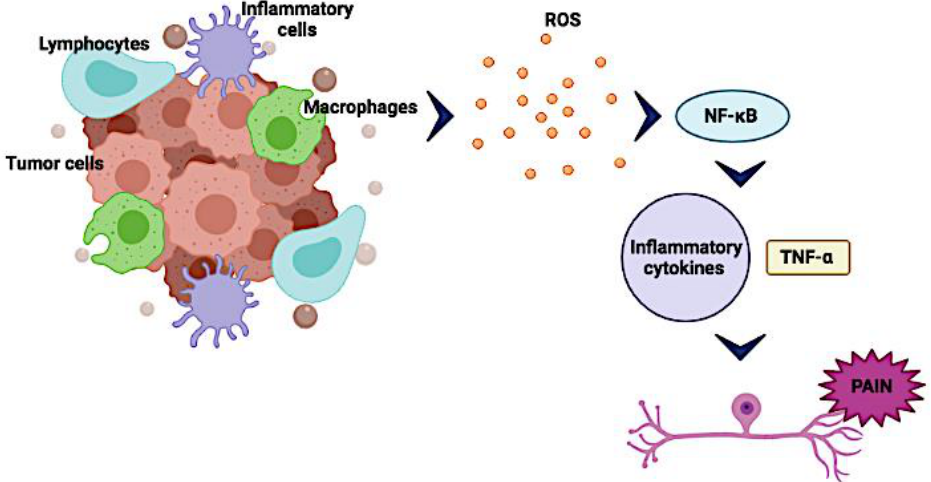
Figure 2. The tumor microenvironment and pain. Interactions between different types of cells present in the tumor are associated with inflammatory processes that induce the release of reactive oxygen species (ROS) regulating the NF- κB pathway within the hypoxic tumor microenvironment. Under these conditions, the activation of NF- κB, particularly in tumor cells and macrophages, induces the secretion of interleukin-6 (IL-6) and tumor necrosis factor-alpha (TNF- α), which sensitize nociceptors associated with pain. Created with BioRender.com, accessed on 28 June 2021.